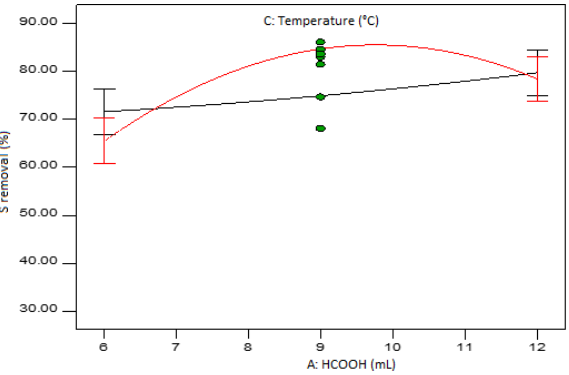
Figure 7: Interaction plot of formic acid amount and temperature at mid-level reaction time and hydrogen peroxide amount.